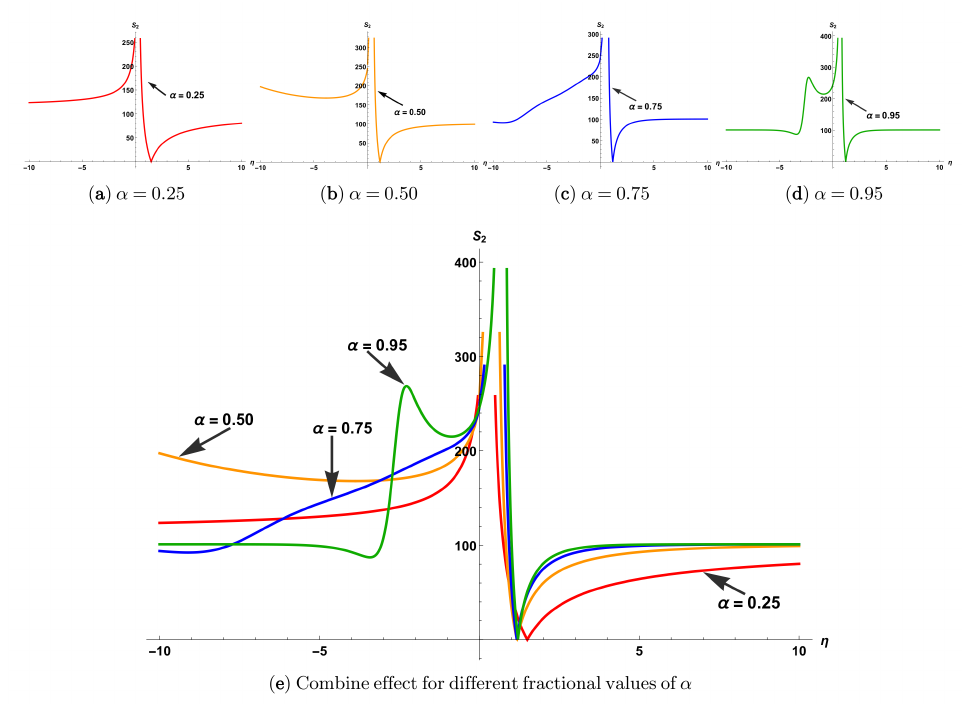
Figure 5. A 2D graphical representation for S 2 .